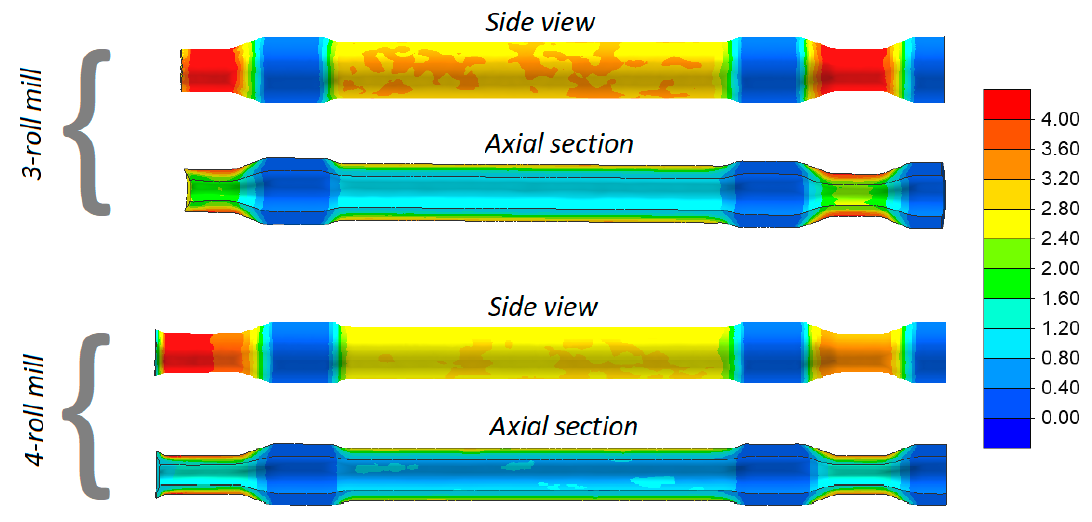
Figure 13. Effective strains in skew rolled hollow axles. Figure 13. E ff ective strains in skew rolled hollow